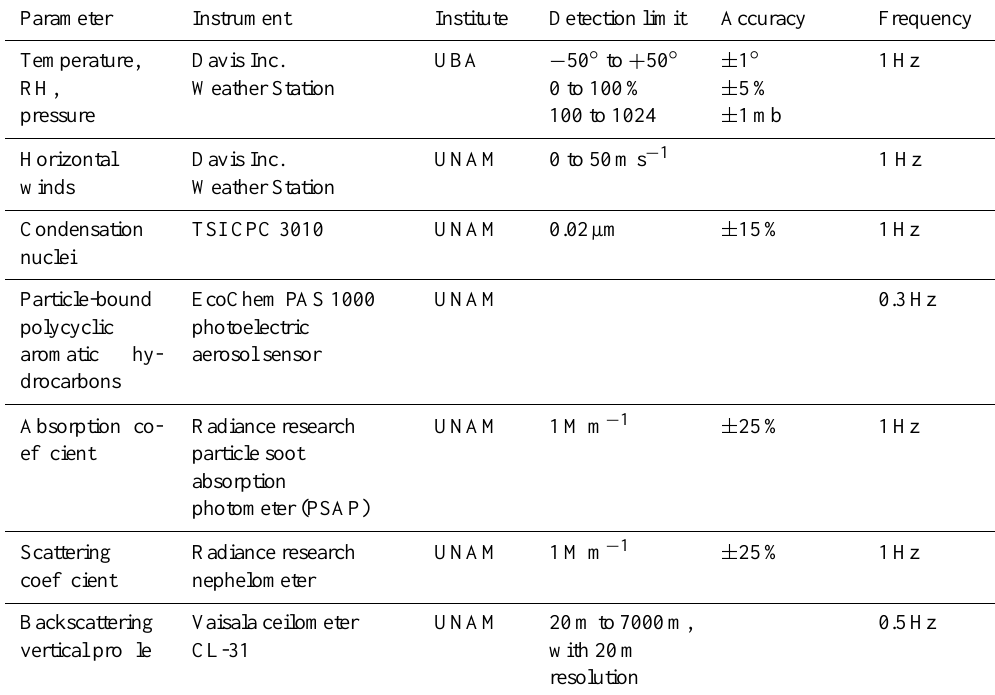
Table 2. Description of instrumentation deployed at the research site at the Facultad de Ciencias Exactas y Naturales, Universidad de Buenos Aires (FCEN, UBA). The acronym UNAM corresponds to Universidad Nacional Autónoma de México. Institute Detection